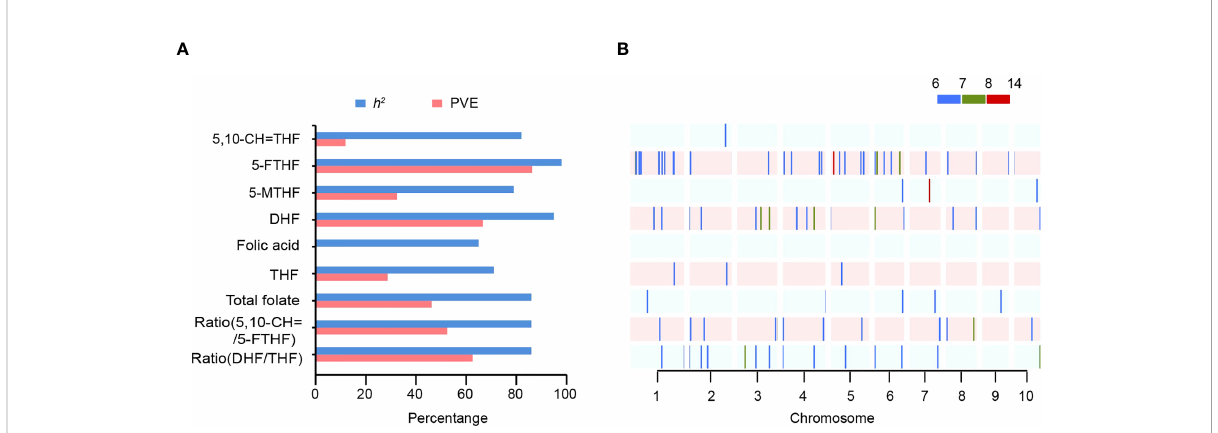
FIGURE 2 Summary of signi fi cant sites for folate traits identi fi ed by GWAS. (A) Broad-sense heritability ( h 2 ) and total PVE for each folate trait in the population. (B) Distribution of signi fi cant sites on chromosomes. Regions across the maize genome are represented within 35 kb of the most signi fi cant site intervals, and – log 10 ( P -value) are scaled by